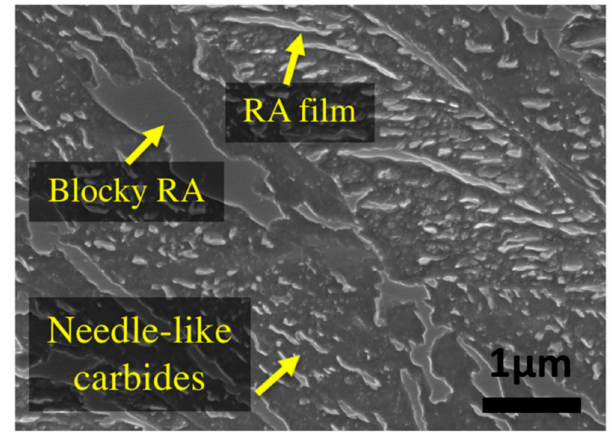
Figure 1. Primary microstructure of bainite with retained austenite before